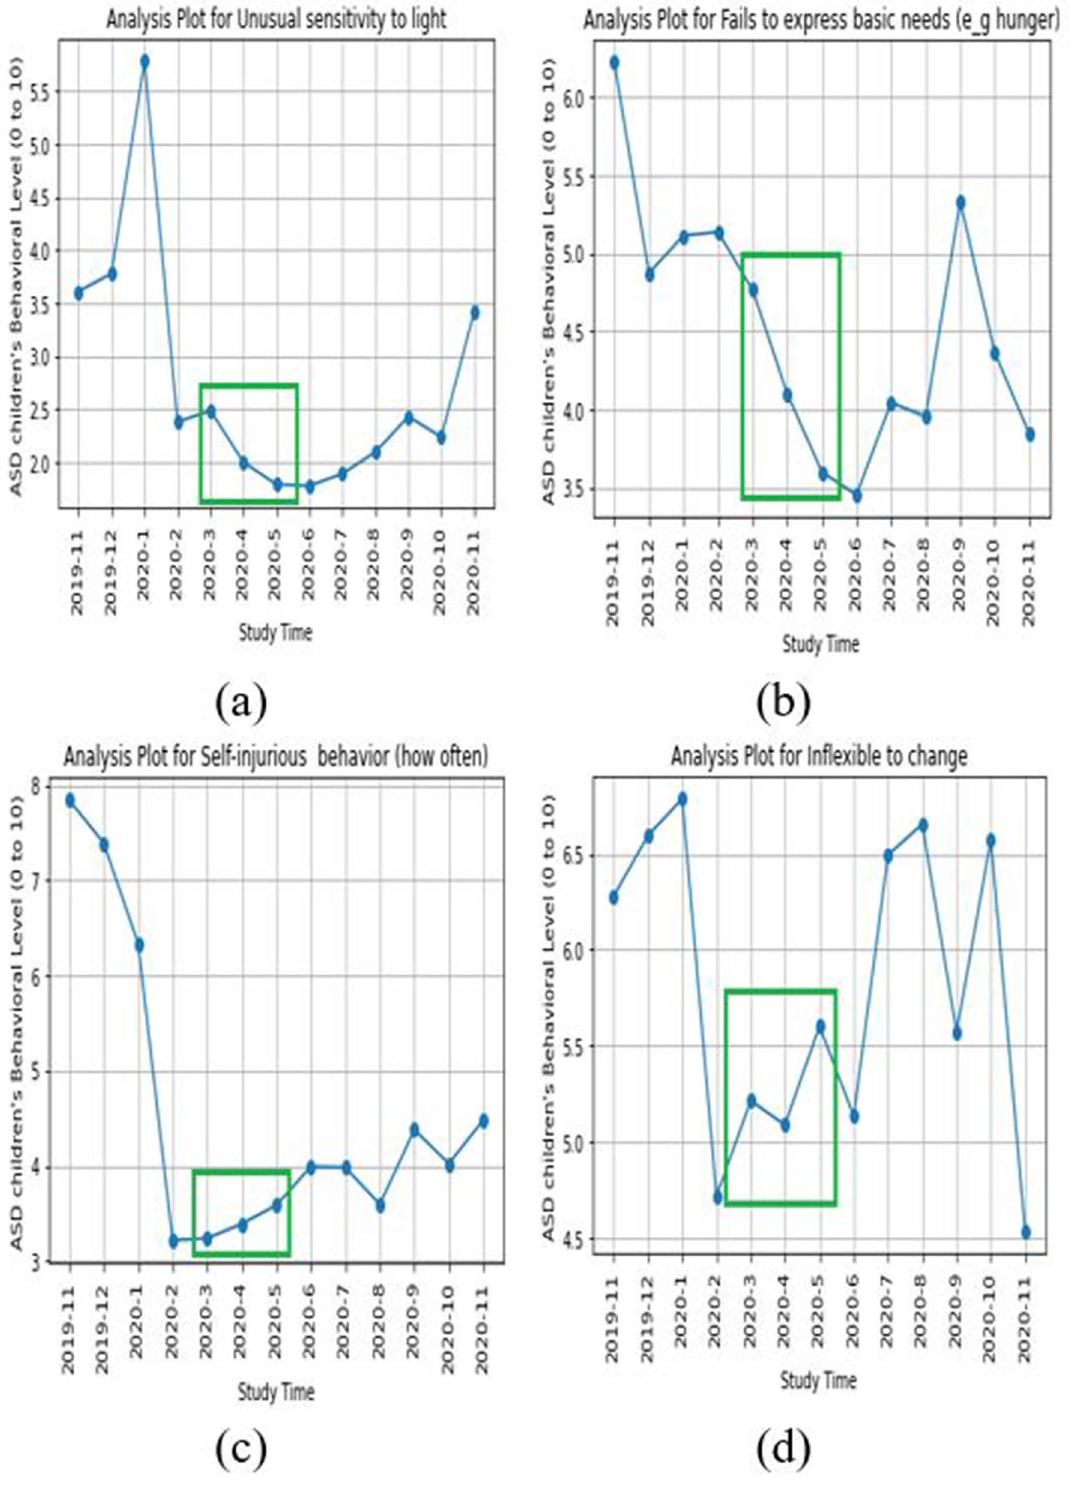
Figure 3. Graphical representation of the “positive change” due to lockdown on children’s with ASD behavioral parameter: ( a ) Unusual sensitivity to light, ( b ) Fails to express basic needs (e.g., hunger), ( c ) self-injurious behavior (how often), and ( d ) Inflexible to